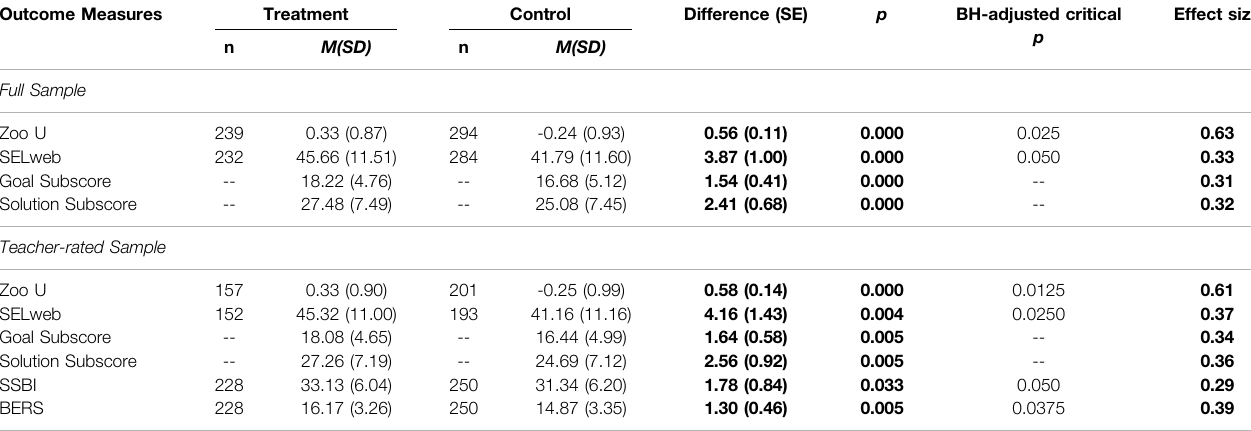
Table 5 | The effect of Adventures on student social-emotional skills Outcome